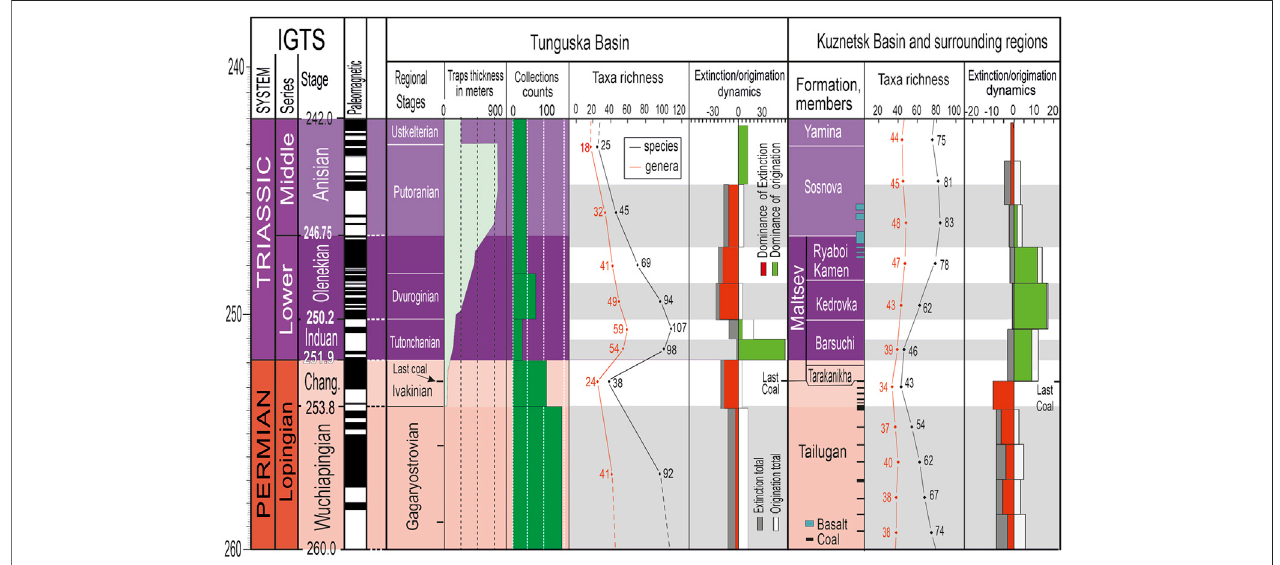
FIGURE4 | The taxonomicrichness and dynamics ofthe extinction and originationof fl ora in Norilsk and Kuznetsk Basinscalculated using functions implemented in the R-package divDyn (Kocsis et al., 2019). A similar pattern of these parameters is observed in both regions. The fl oral richness and species origination in the Tunguska and Kuznetsk basins roughly correpsponds with the onset of the ma fi c magmatism (Late Permian) and climatic optimum in both regions.